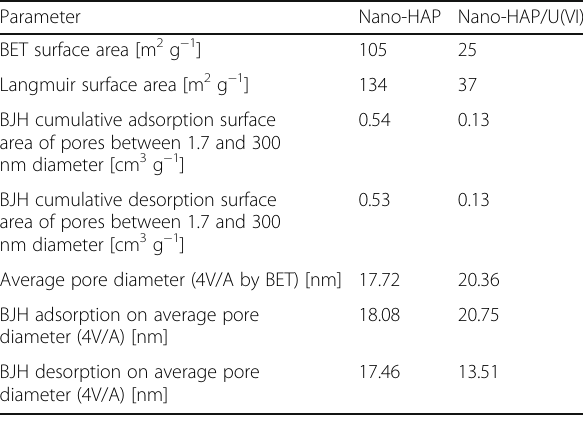
Table 1 Chosen structural parameters for nano-HAP and nano-HAP/U(VI) Parameter